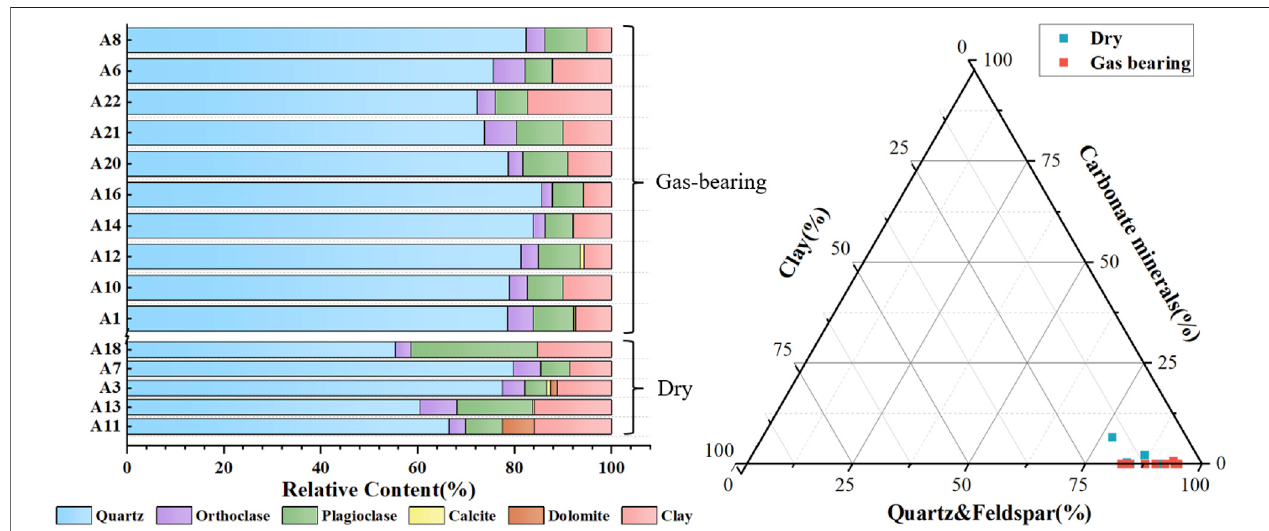
FIGURE4| Mineralogycomparison (stacked bar chart ontheleft and ternaryplot ontheright) betweensamplesfrom gas-bearing formationand the dryformation based on XRD data.